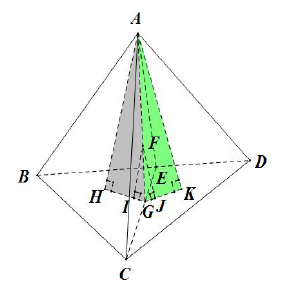
Figure 3. Proof of the continuity of TIS between two adjacent